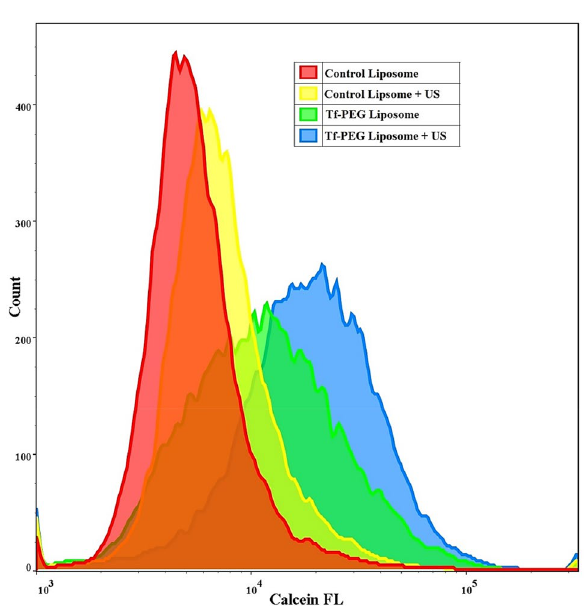
Figure 9. Calcein uptake by HeLa cells incubated with control and Tf-PEG liposomes and exposed to LFUS (35-kHz). Results are the average ± standard deviation of three liposome batches (3 replicates